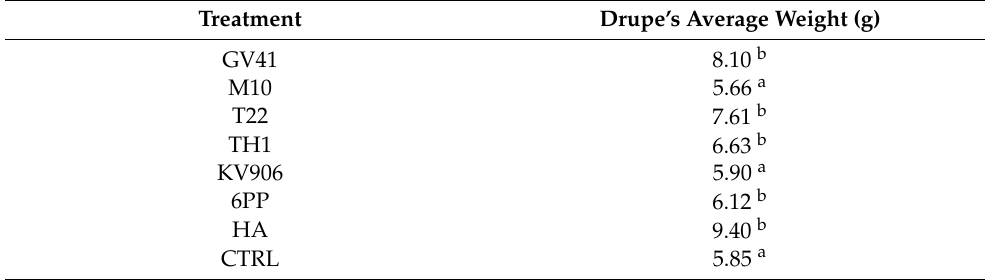
Table 1. Effects of treatments with Trichoderma spp. strains T22, M10, GV41, TH1, KV906 or its metabolites 6-pentyl- α -pyrone (6PP) and harzianic acid (HA) on average weights of the drupes collected from the experimental field. The control (CTRL) was not treated with biostimulants. Treatment